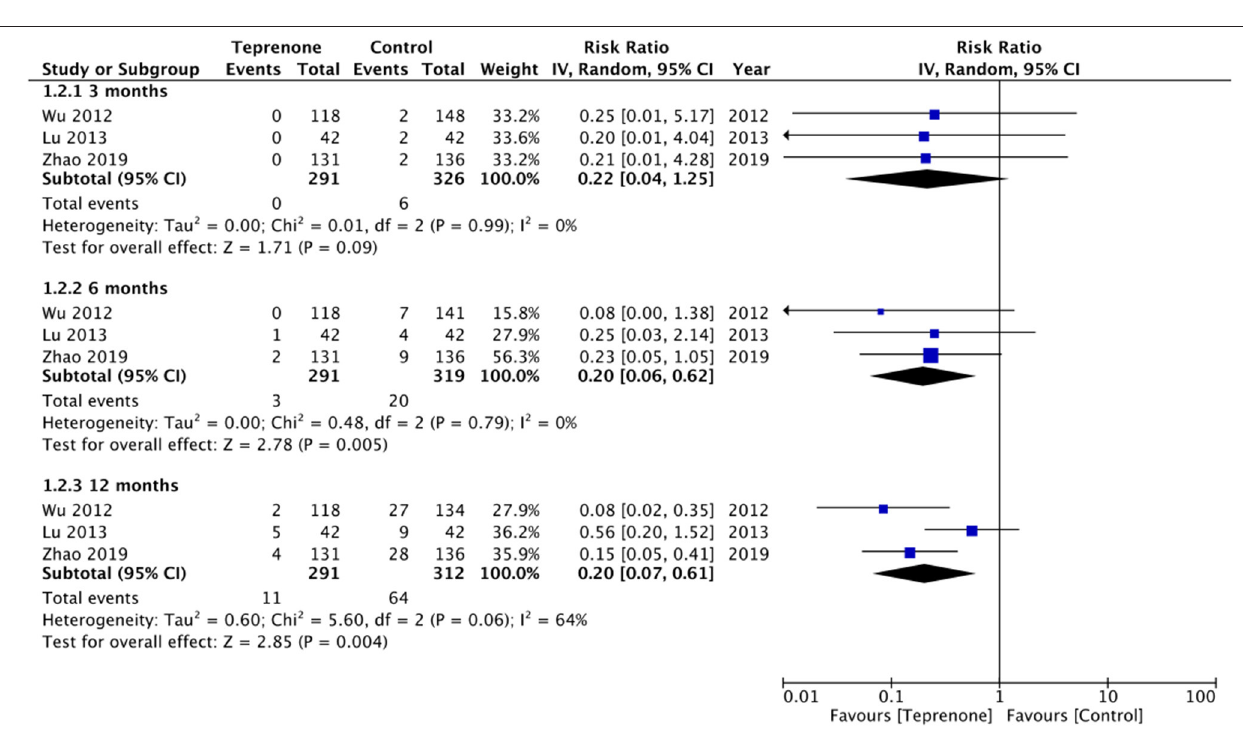
FIGURE 3 | Forest plot for incidence of GI symptoms between teprenone vs. control with sub-group analysis based on duration of